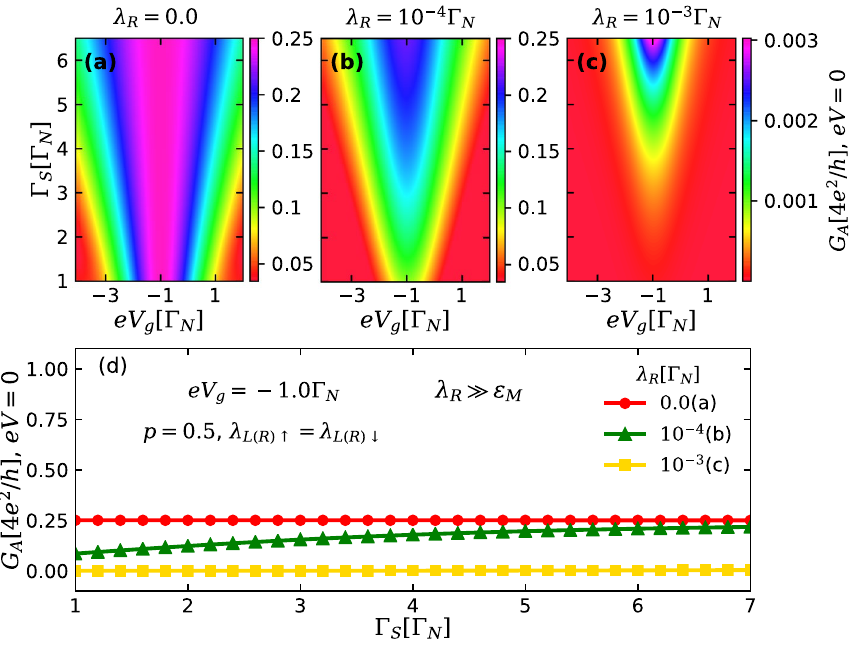
Figure 7. ( a – c ) Color scale plots of the Andreev conductance G A [Eq. (5)] at zero-bias as a function of the QD-S hybridization strength Ŵ S and QD gate-voltage eV g for spin symmetric case ( p considering three distinct values of the parameter the QD-right MBS coupling (cid:31) R defining the nonlocality of ε M . One can easily verify an isconductance line with G A ( eV the MBSs for (cid:31) R ≫